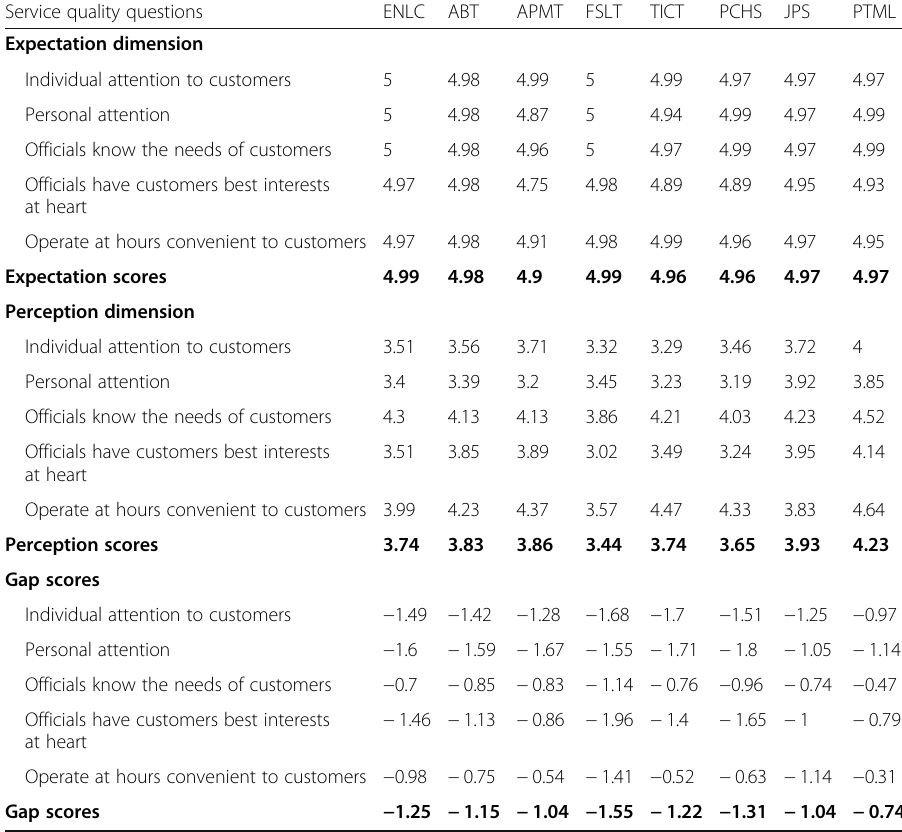
Table 8 Service quality expectation and perception average scores for empathy Service quality questions ENLC ABT APMT FSLT TICT PCHS JPS